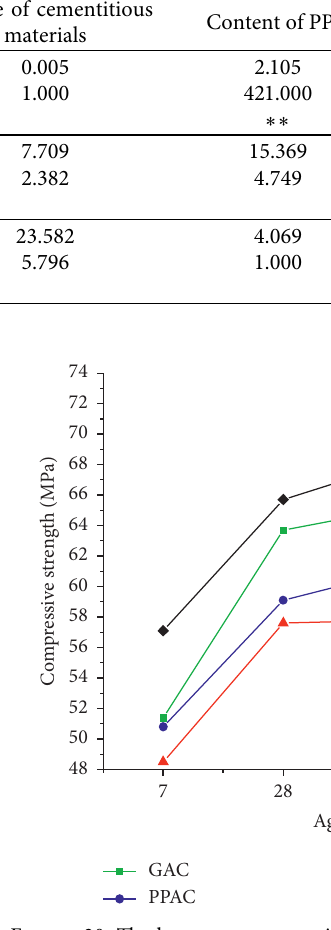
Figure 20: The long age compressive strength of oil shale cement slag